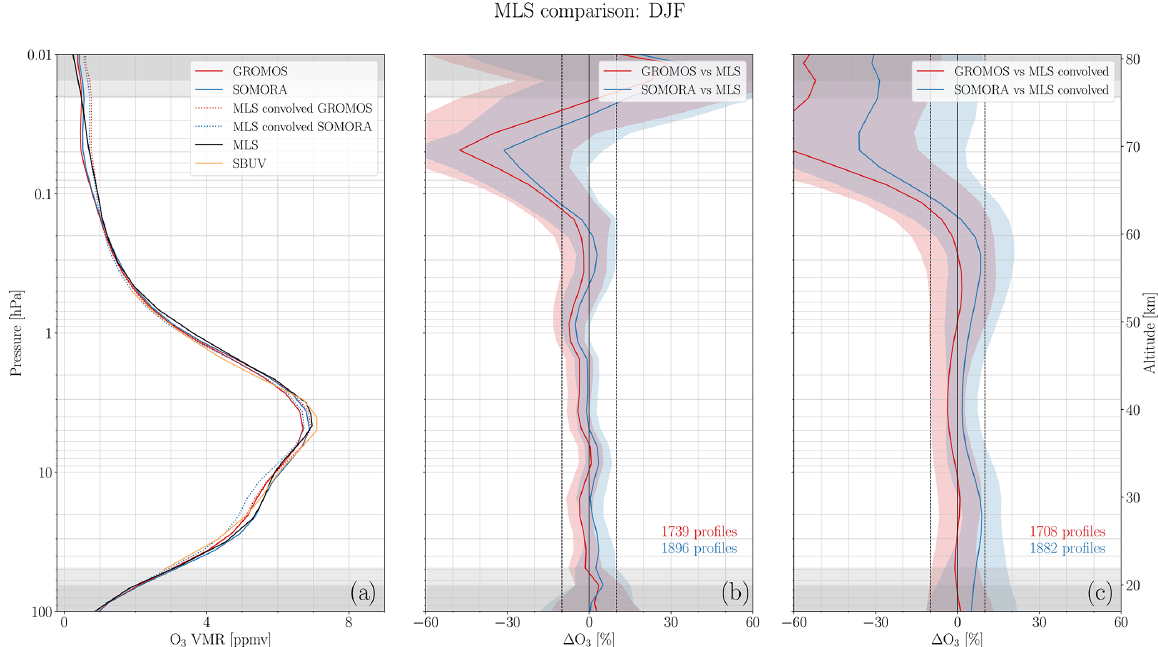
Figure 11. Seasonal comparison with MLS and SBUV during winter months (December, January and February). Panel (b) shows the relative differences with MLS, whereas panel (c) shows the relative differences with the convolved MLS profiles. The coloured areas show the standard deviation of the differences with MLS, and the grey shading indicates the limits where the a priori contribution exceeds 20%. The dashed vertical lines indicate the ± 10% interval.